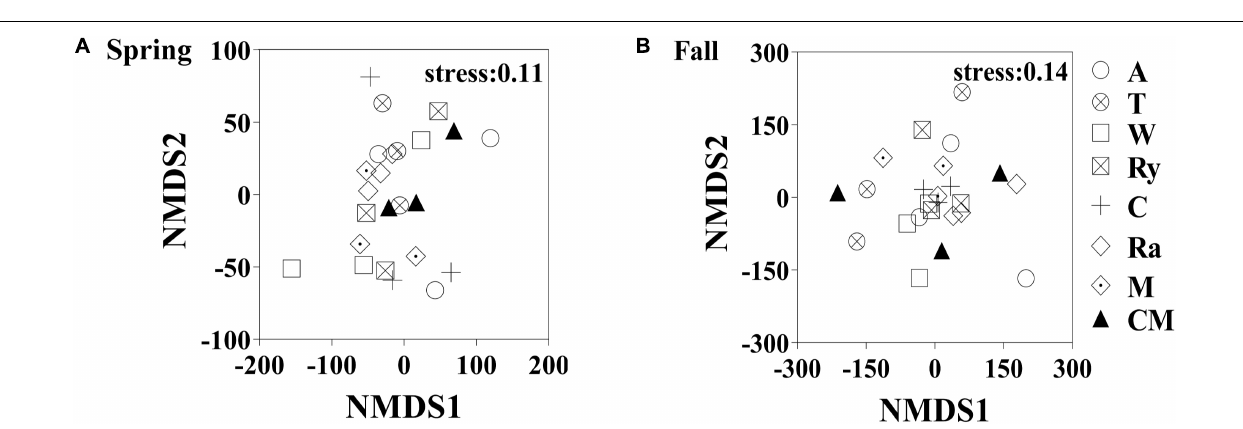
FIGURE 6 | Non-metric multidimensional scaling (NMDS) analysis of the diazotrophic communities in the (A) spring (S) and (B) Fall (F) cropping seasons.